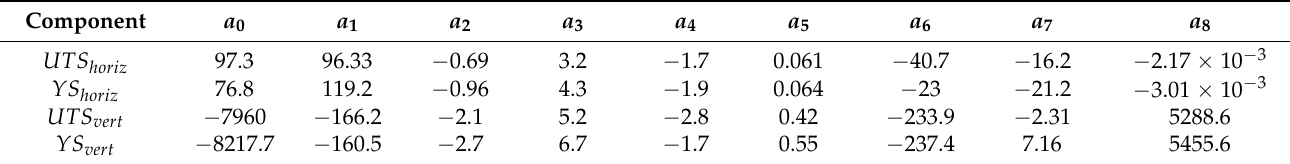
Table 10. Calculated coefficients for the linear regression models of horizontal and vertical compo- nents of UTS and YS .